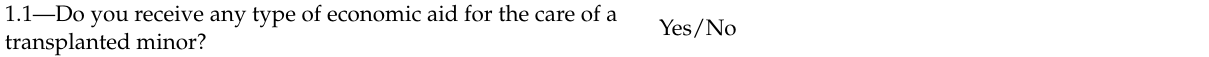
Table 1. Long-term financial assistance of the Social Resource Survey. Main (numbered) and additional questions and answers are